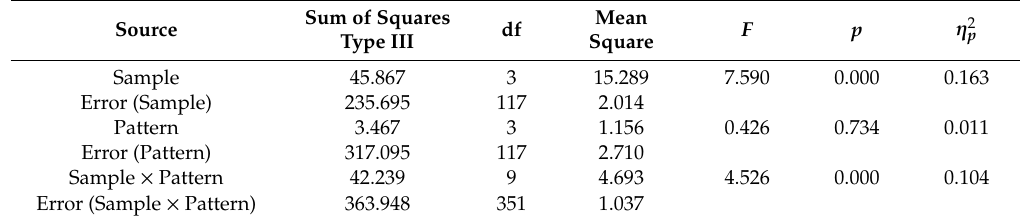
Table 7. Results of four-way mixed ANOVA for grip comfort (Test result of within subject e ff